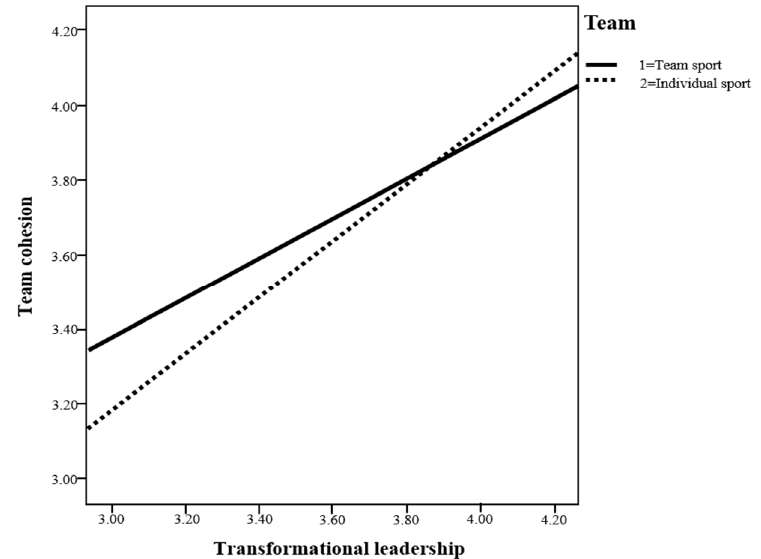
Figure 2. Transformational leadership and the moderating effect of individual/team sport athletes.